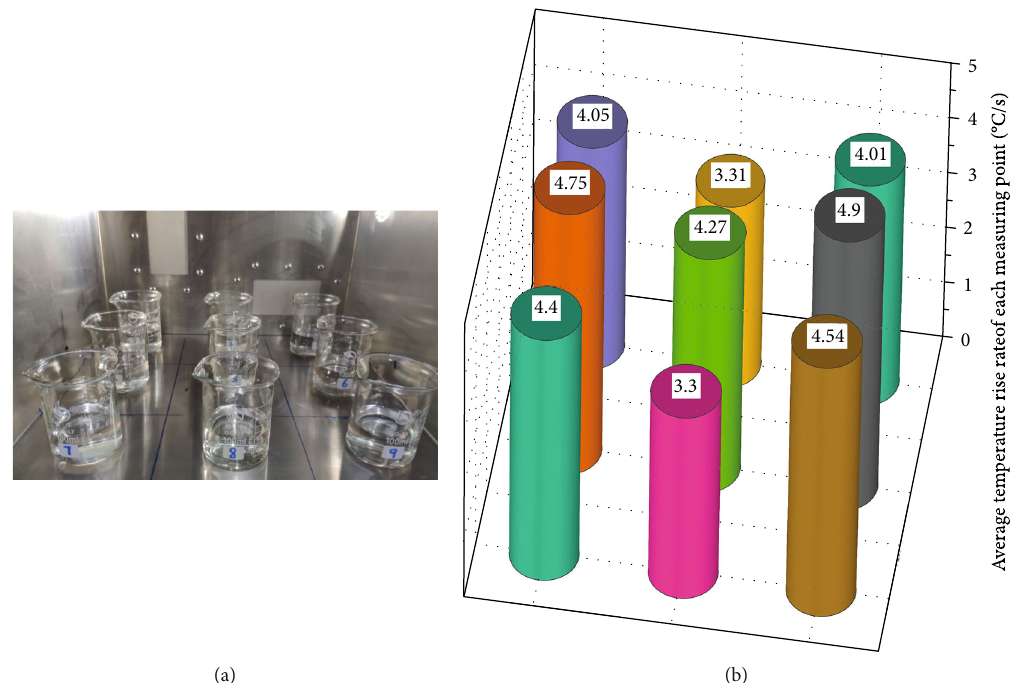
Figure 9: (a) Microwave electric fi eld intensity test by the water-loading method. (b) Distribution of test results of the heating rate in the microwave